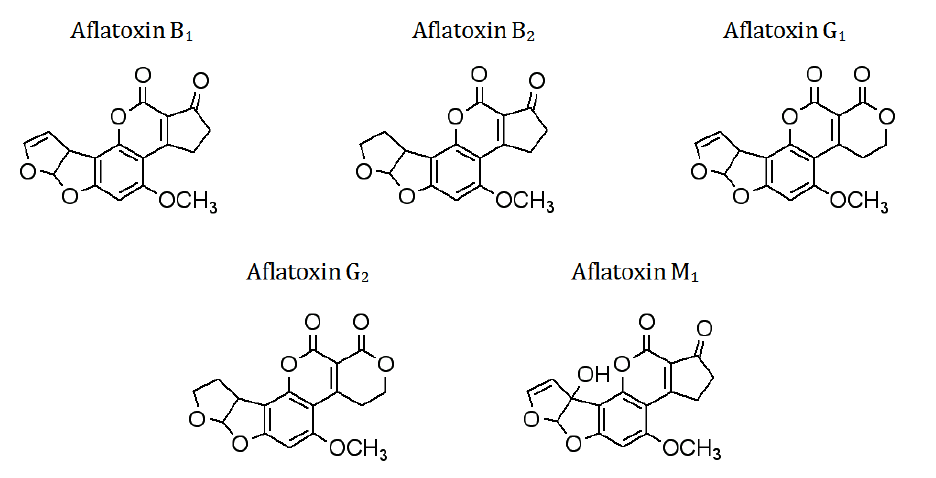
Figure 7. Structures of commonly encountered